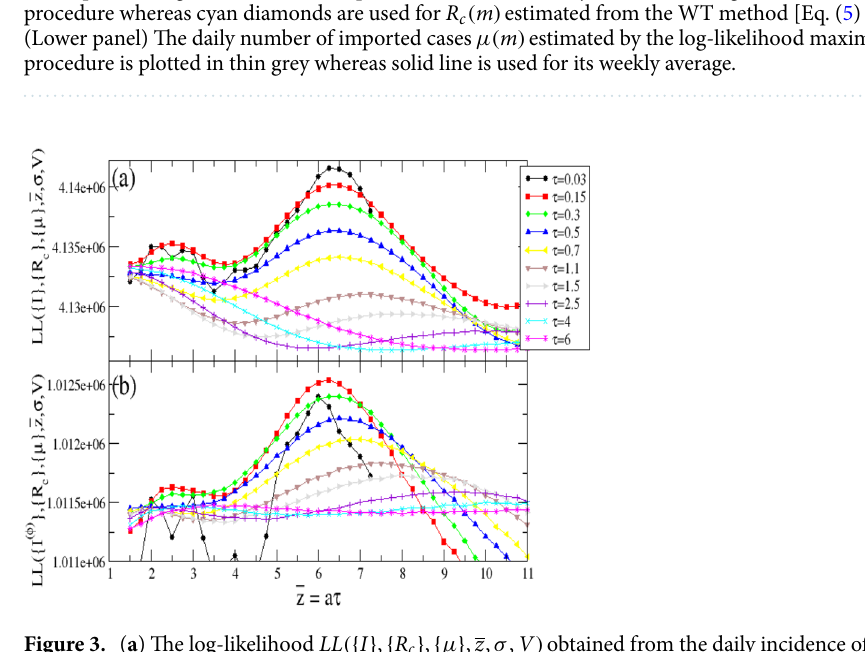
Figure 3. ( a ) The log-likelihood LL ( Lombardy, is plotted as a function of z a √ τ . ( b ) As in the upper panel for LL a different σ = 5 E 4 φ φ ∗ = = −